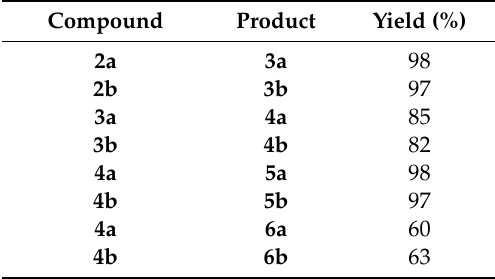
Table 2. Sensitivity of human pathogenic microbes to the new synthetic heterocyclic compounds using the hole